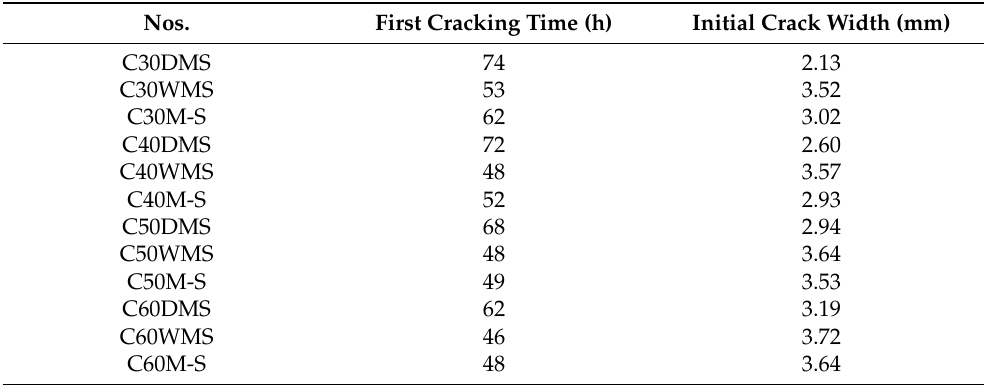
Table 8. First cracking time and initial crack width of each group. Nos. First Cracking Time (h) Initial Crack Width